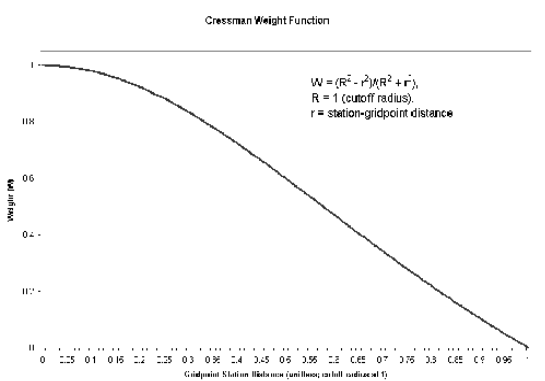
Figure 5. Inverse Distance Weighted